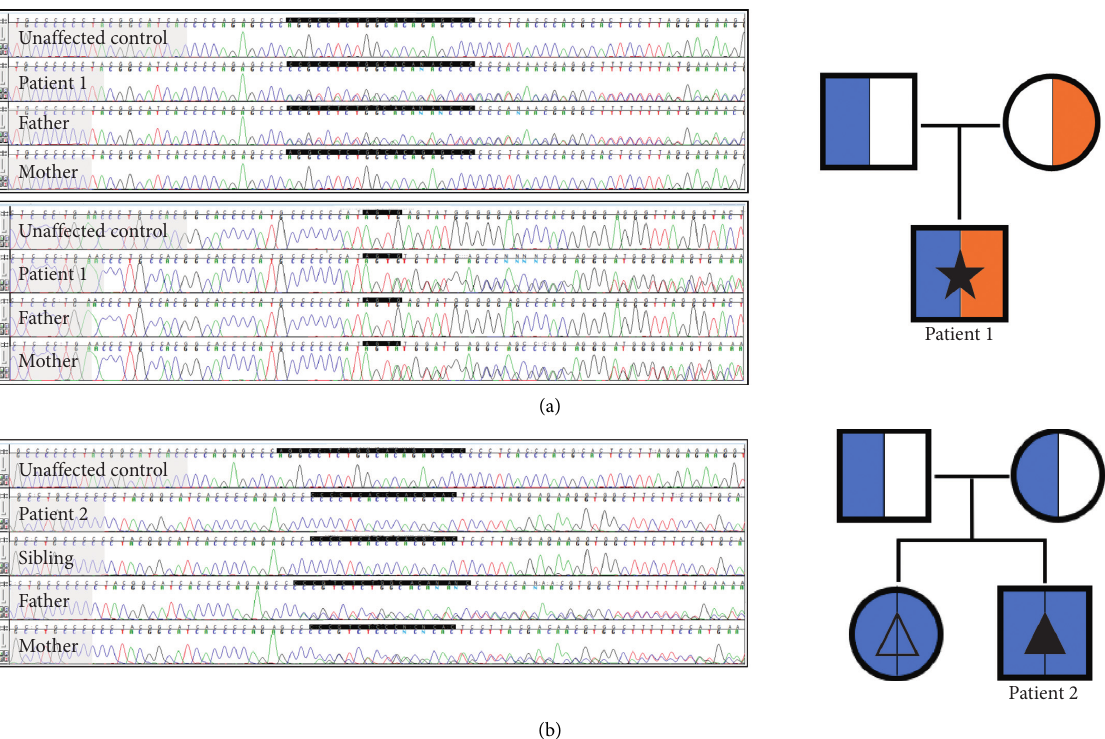
Figure 1: Patient 1. (a) Chromatograms (top: paternally inherited c.767_786del, bottom: maternally inherited c.2177+3_2177+6delGAGT). Pedigree (blue: c.767_786del, orange: c.2177+3_2177+6delGAGT, solid star: ectopia lentis with craniosynostosis). Patient 2. (b) Chromatogram (recessively inherited c.767_786del). Pedigree (blue: c.767_786del, solid triangle: ectopia lentis et pupillae with cranio- synostosis, open triangle: isolated ectopia lentis et